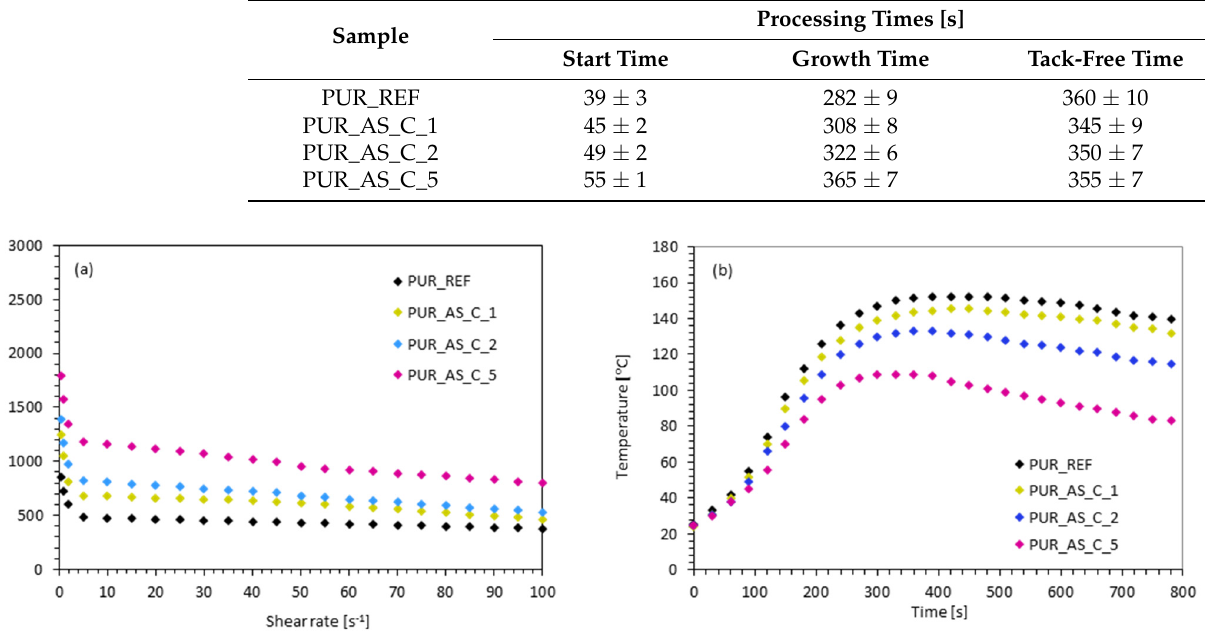
Figure 6. ( a ) Dynamic viscosity of PUR systems modified with casein/apricot filler and ( b ) maximum temperature measured during the synthesis of PUR composites.